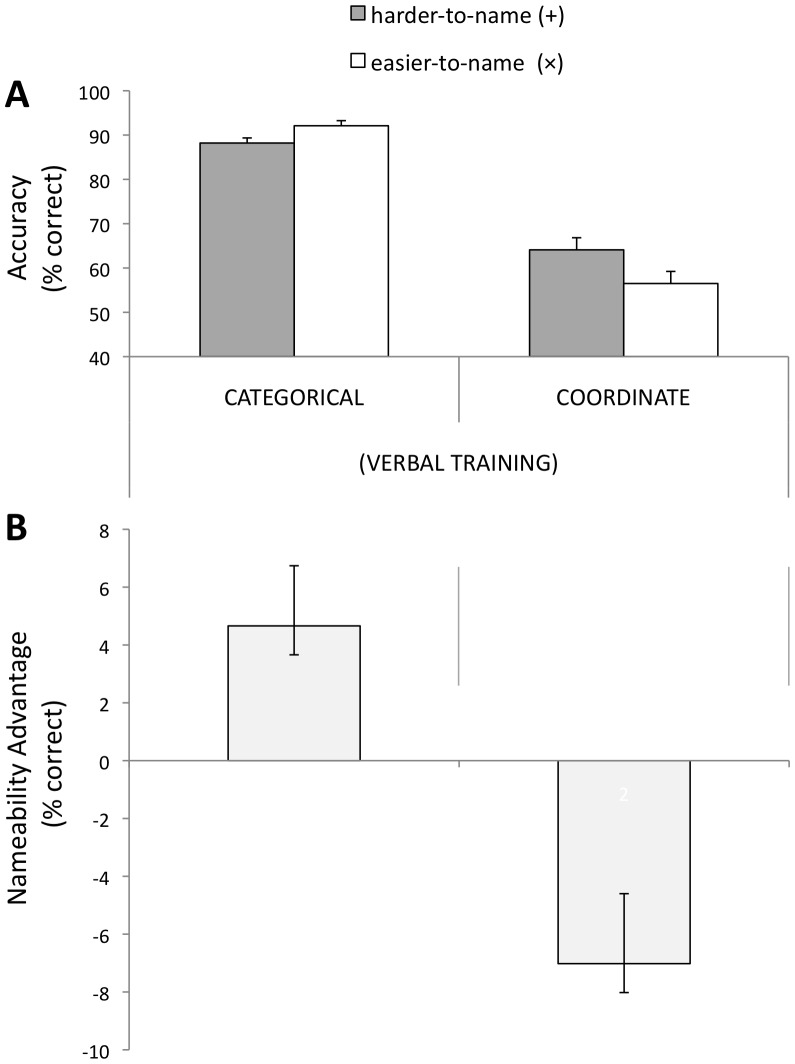
Accuracy results for Experiment 3 (verbal training).(A) Overall % accuracy for all different trials. (B) Nameability advantage (easier-to-name trials minus harder-to-name trials). A positive difference score indicates an advantage on easier-to-name trials; a negative score indicates a disadvantage on easier-to-name trials. Error bars represent 1SE of the mean difference between easier-to-name and harder-to-name trials.